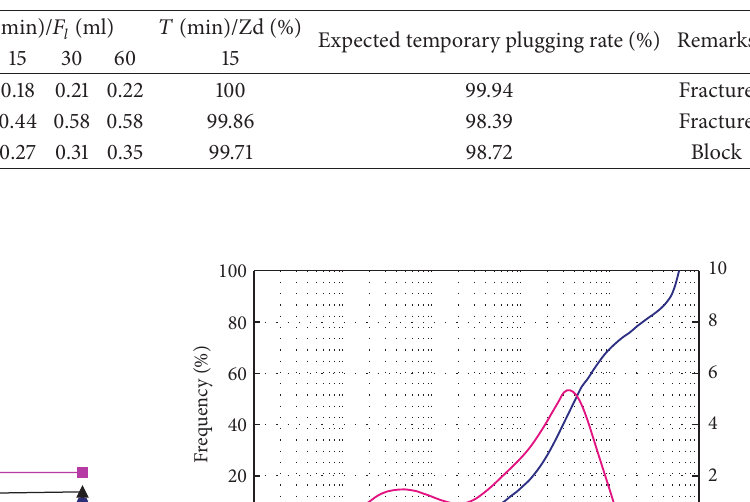
Table 4: Evaluation results of the temporary plugging performance of the shielding ring.